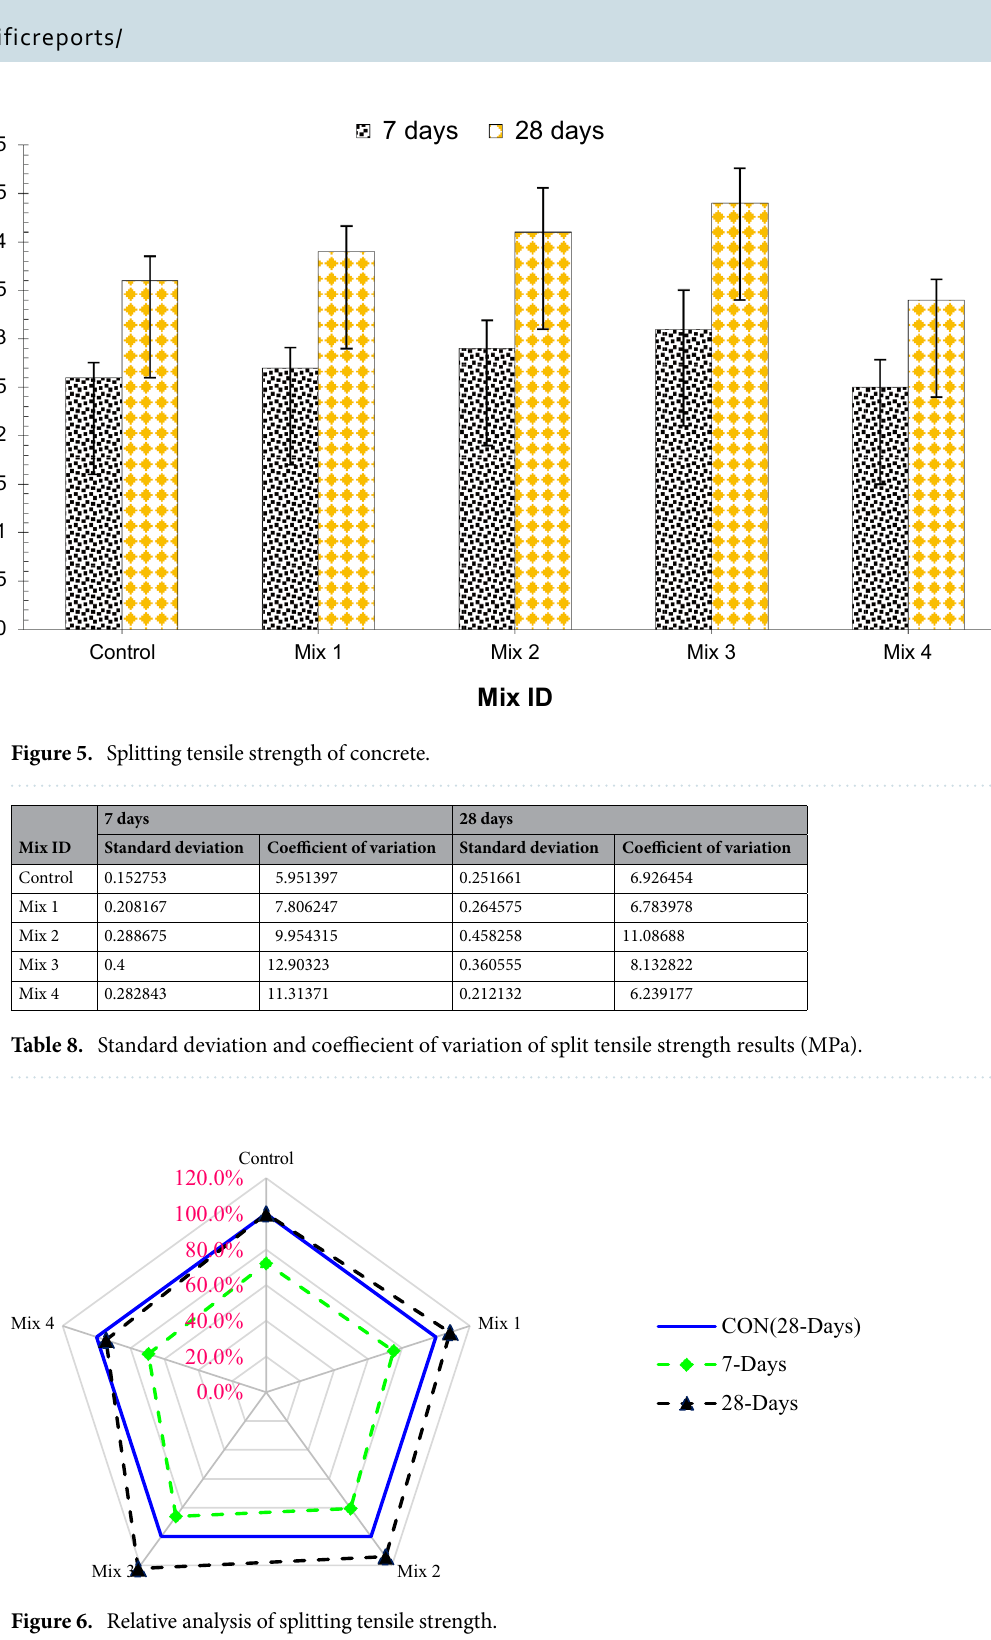
Figure 6. Relative analysis of splitting tensile